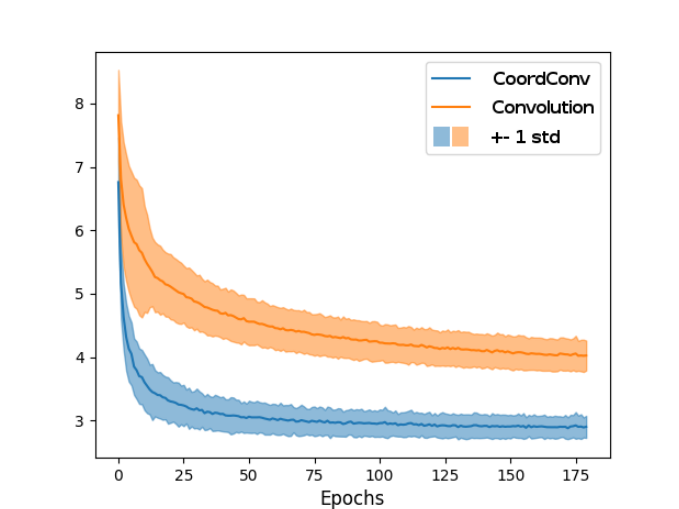
Figure 10. Magnitude and standard deviation of endpoint error for our simple networks trained on our toy dataset. Notice that the network with the CoordConv module converges significantly faster and on lower error values.